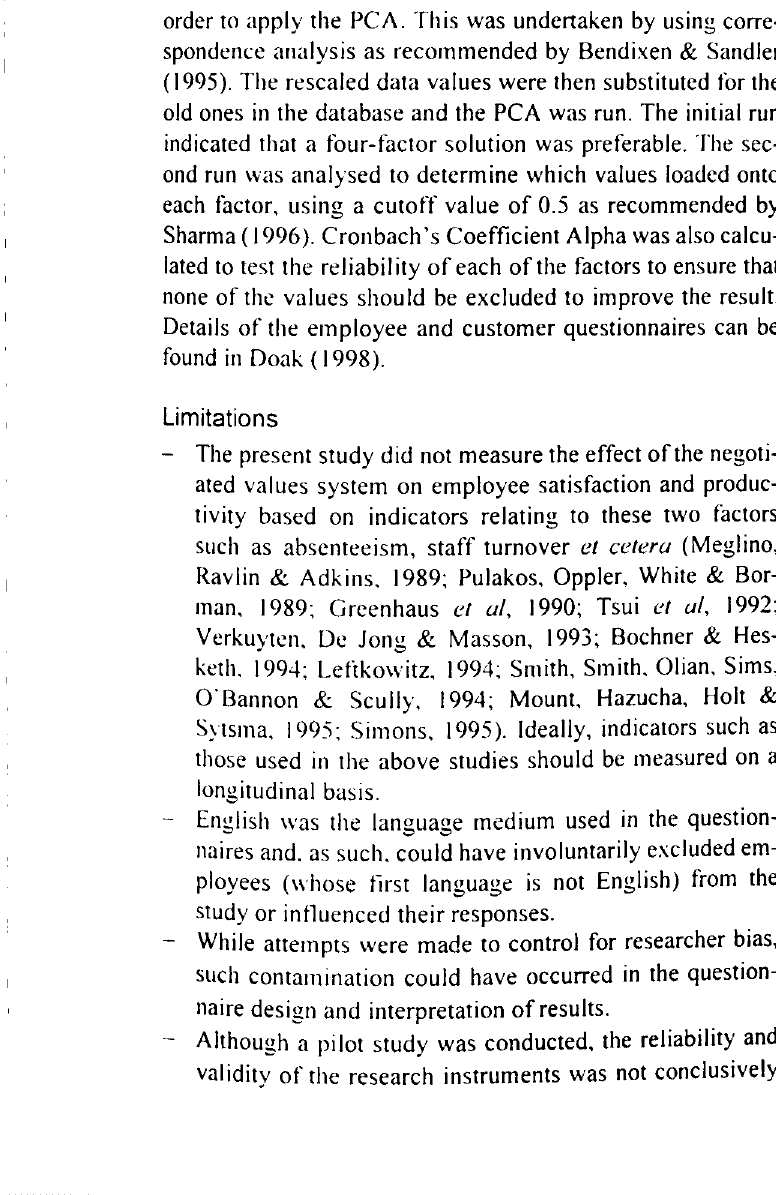
Table 2 Positive features of the values system